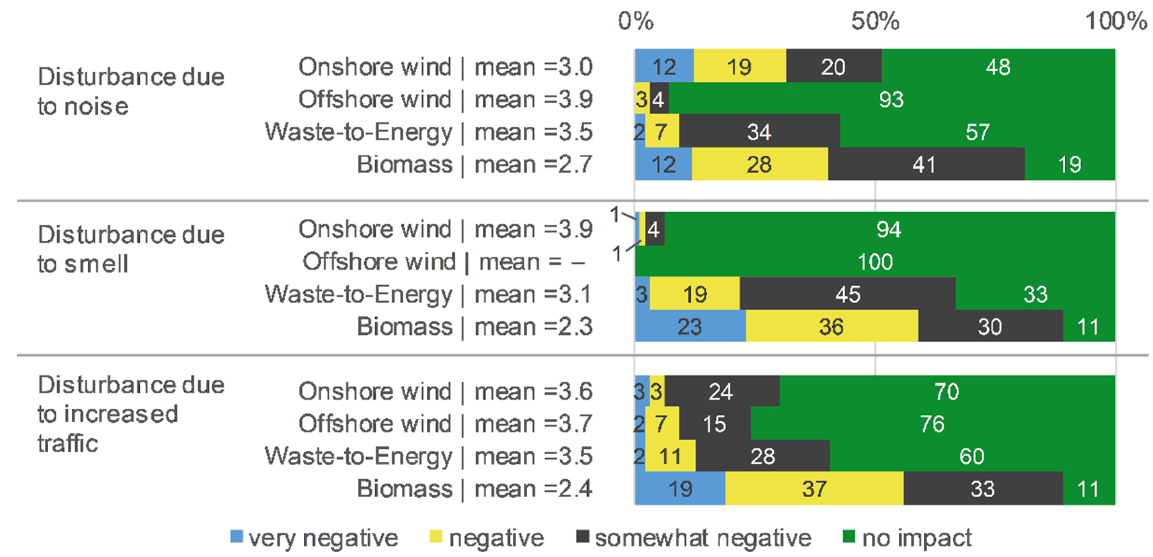
Figure 4. Experienced level of disturbance in the energy neighborhoods in % per survey group. For the calculation of the mean value, a scale from 1: very negative to 4: no impact was used.